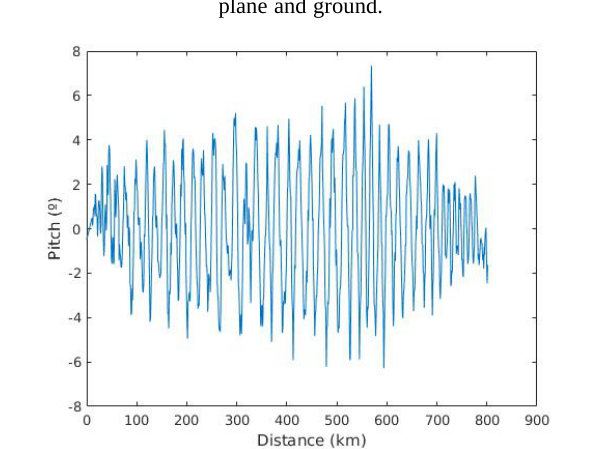
Figure 12. Resolution change in function of distance between plane and ground.